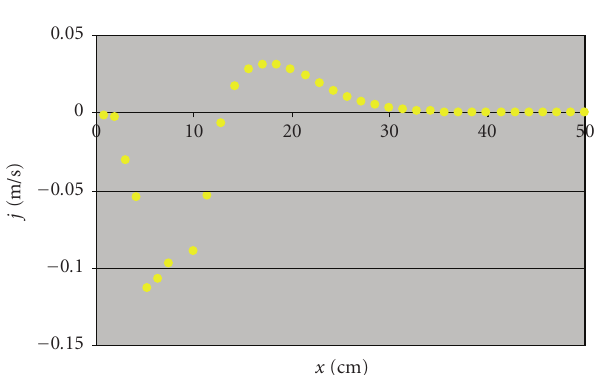
Figure 8: Vertical gas flux density as a function of the horizontal distance to the jet axis, 30 cm below the water level ( C D = 0 . 44).